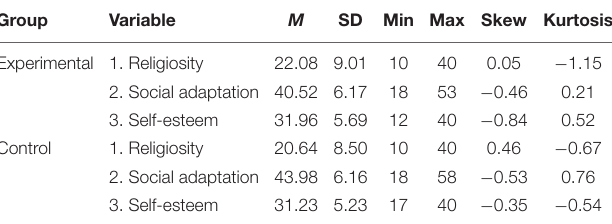
TABLE 1 | Descriptives for study variables per group.